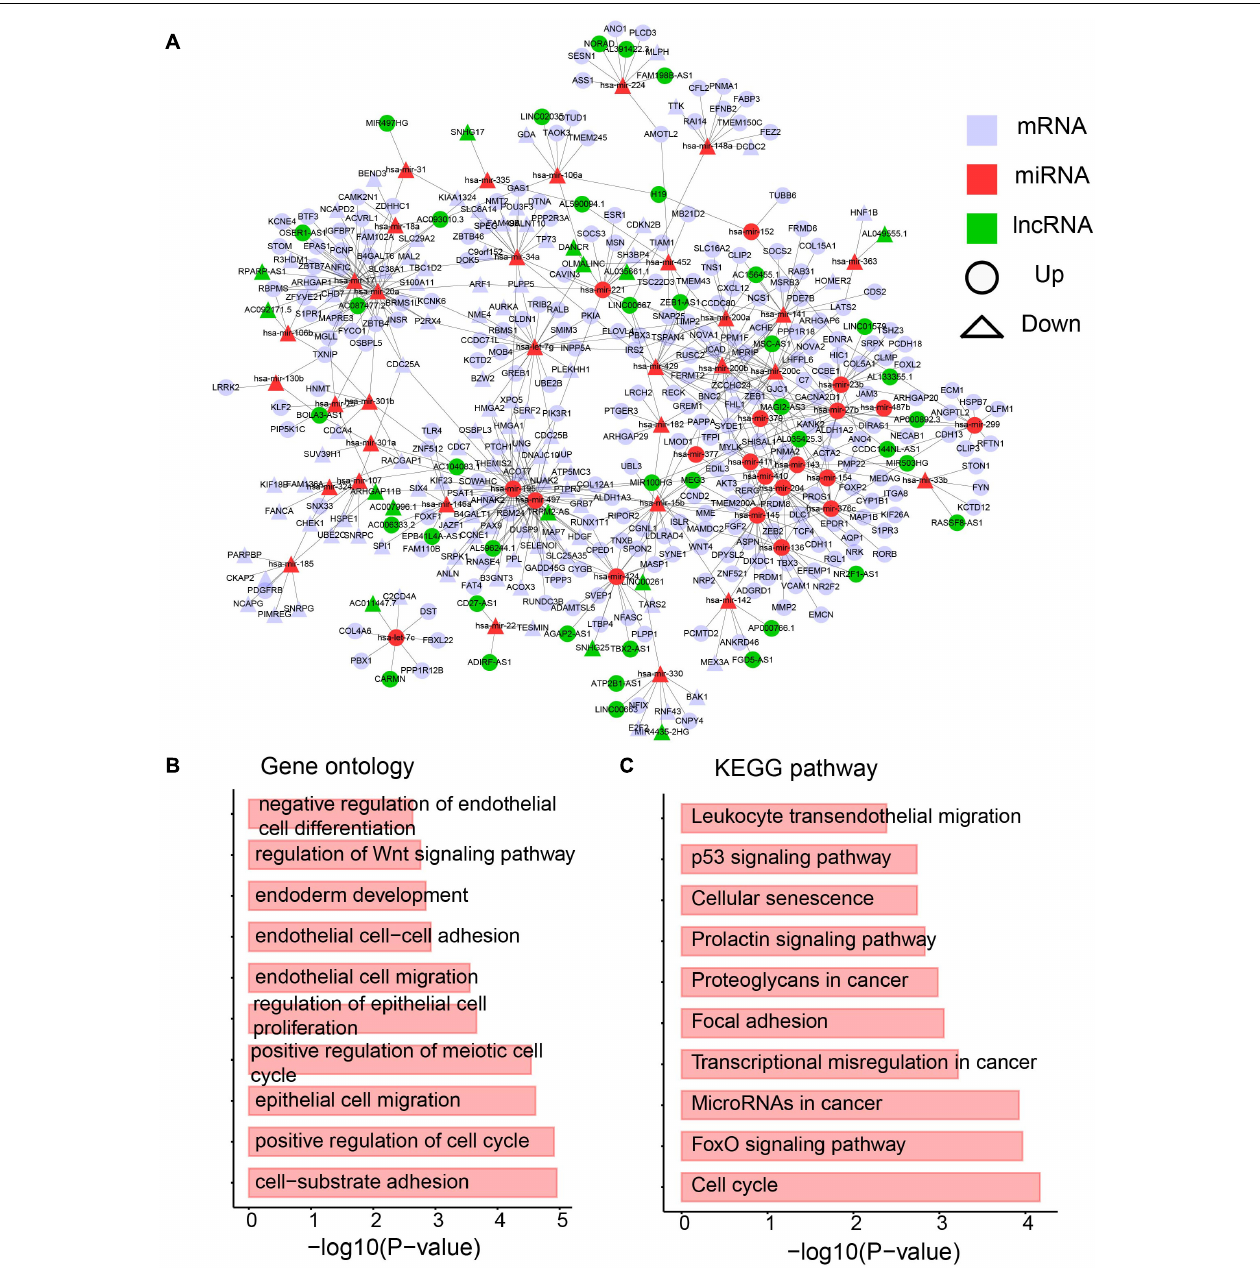
FIGURE 6 | The dysregulated lncRNA-miRNA-mRNA network. (A) The network containing differentially expression mRNA, lncRNA and miRNA. (B) Enriched GO terms. (C) Enriched KEGG pathways.